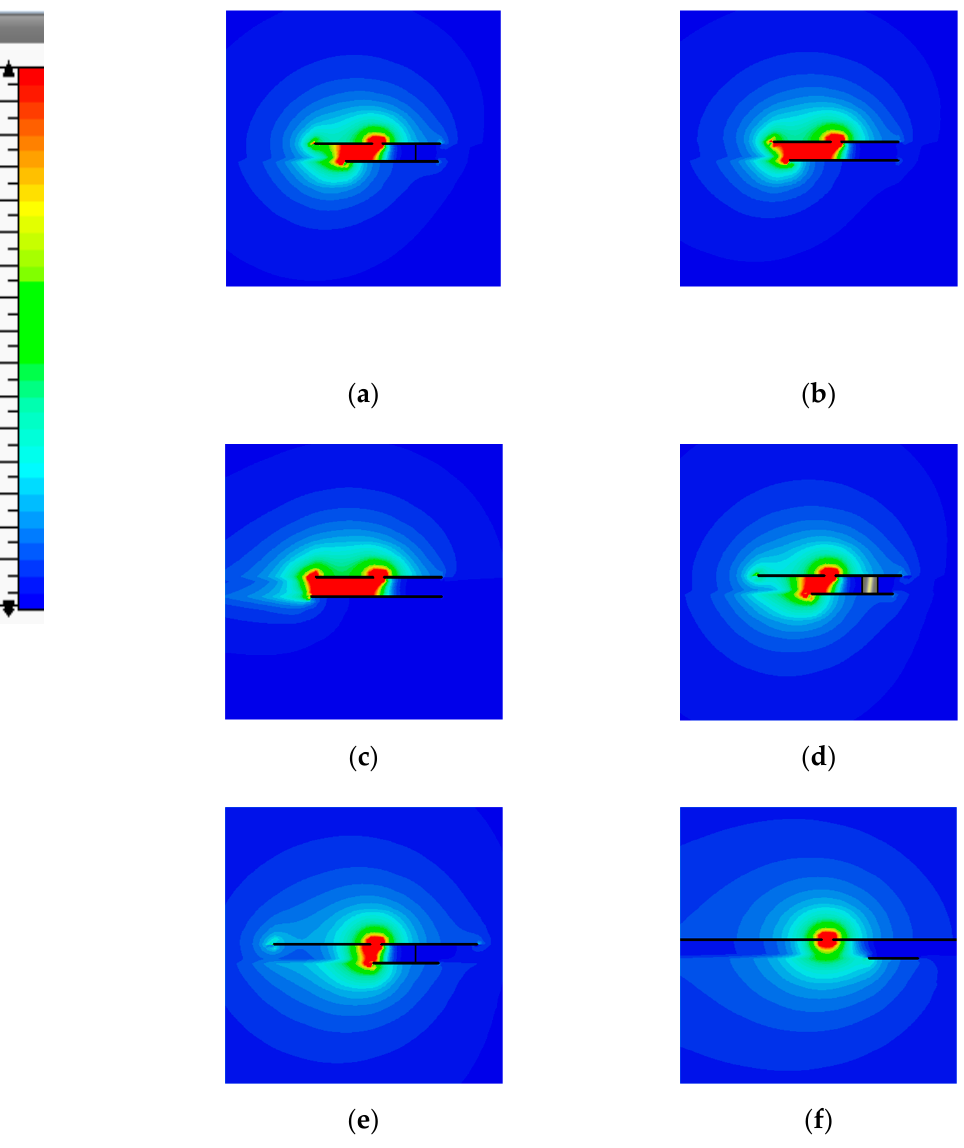
Figure 11. Electric field distributions along the proposed transition: ( a ) 0 mil; ( b ) 100 mil; ( c ) 200 mil; ( d ) 300 mil; ( e ) 400 mil; ( f ) 500 mil position from the microstrip line.